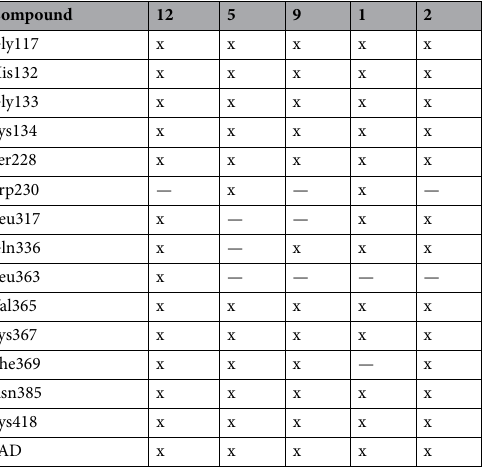
Table 2. Overview of non-covalent contacts between BTZ and BOZ inhibitors with